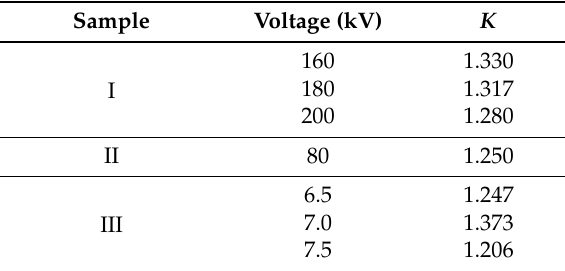
Table 6. Correction Coefficients of different UV imagers.